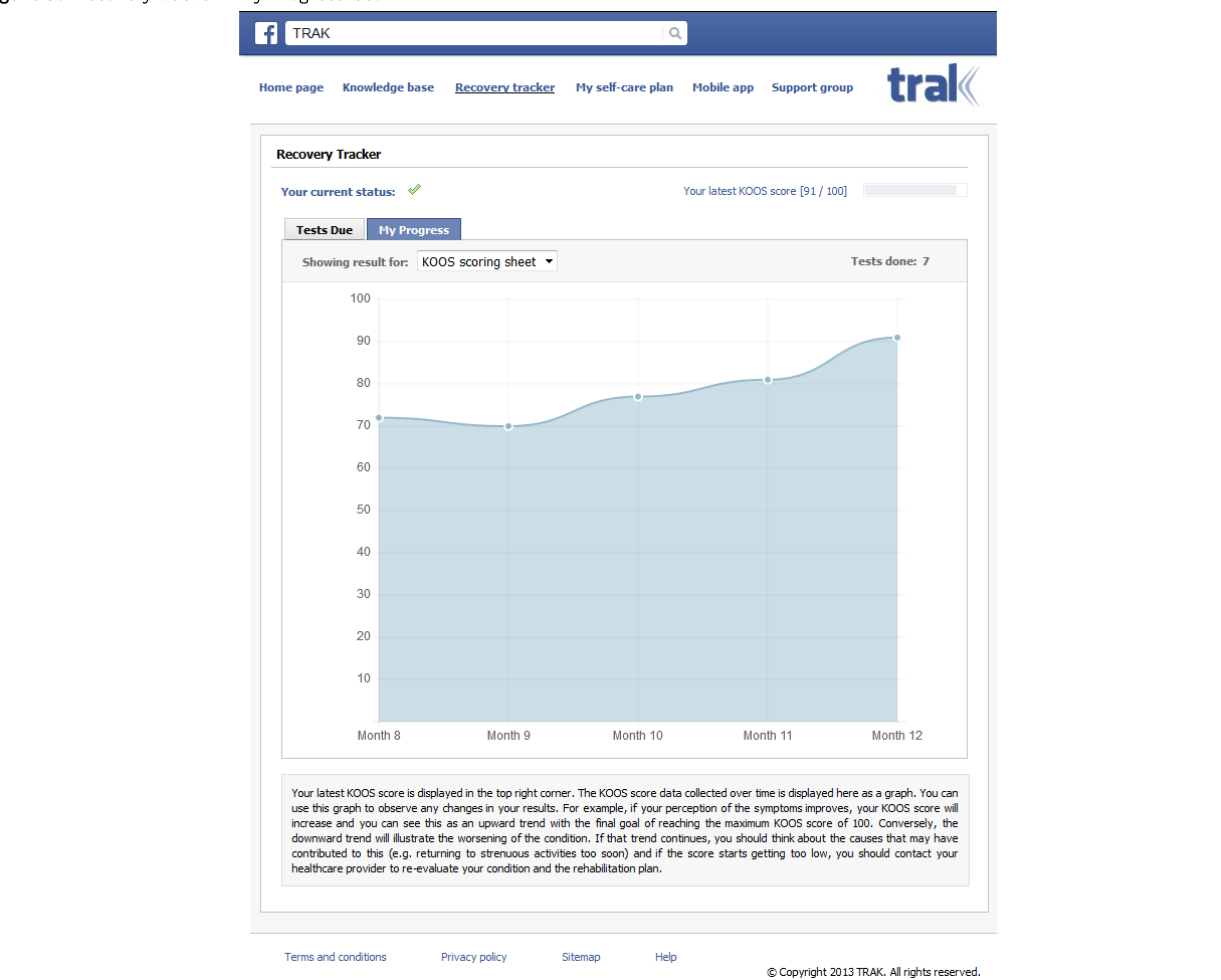
Figure 3. Recovery tracker - My Progress